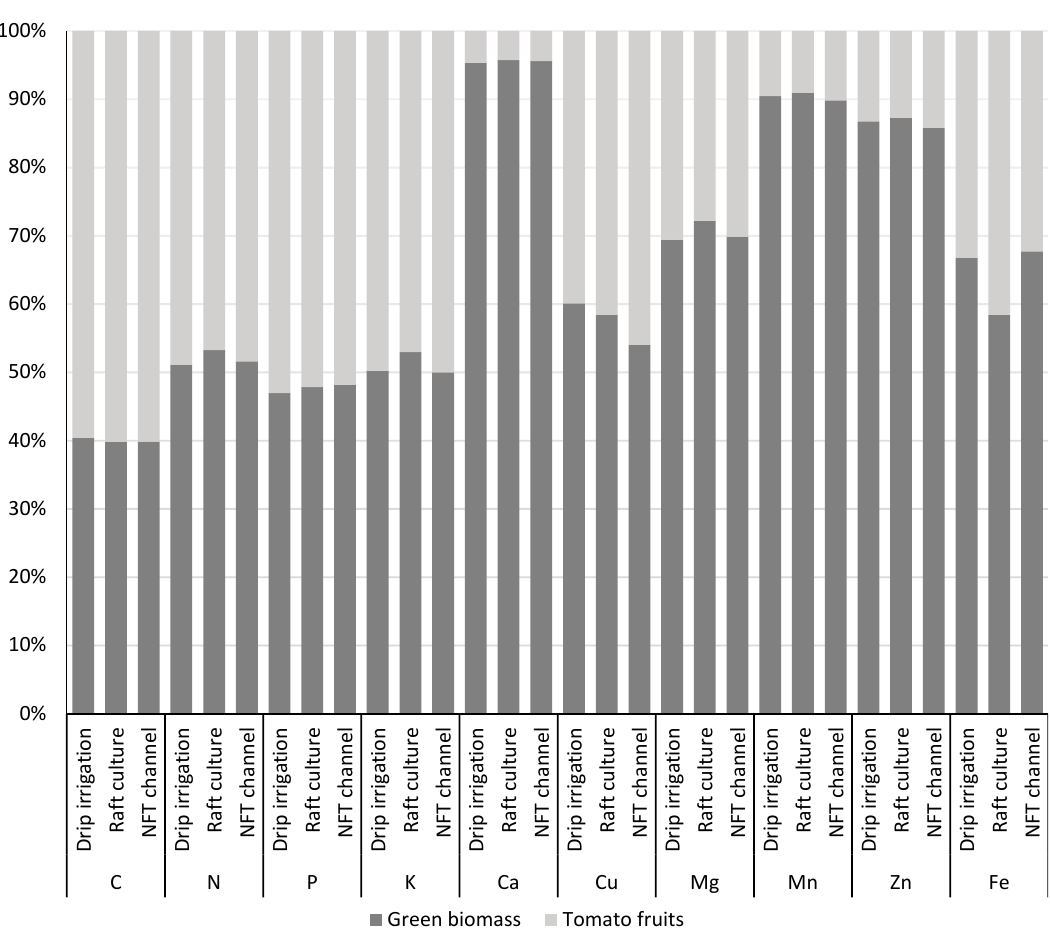
Figure 6. Distribution of total nutrient uptake in the plant in terms of tomato fruits and green biomass in the aquaponic system compared between drip irrigation, raft culture, and nutrient film technique (NFT) system; n = 3.